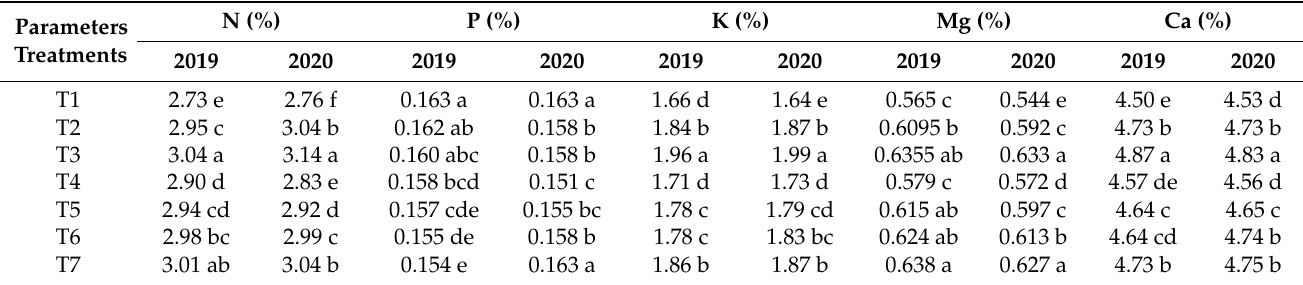
Table 3. Influence of iron (nano, sulfate, and chelated) foliar spray on N, P, K, Mg, and Ca percentages of Washington navel orange trees during 2019 and 2020 experimental seasons.